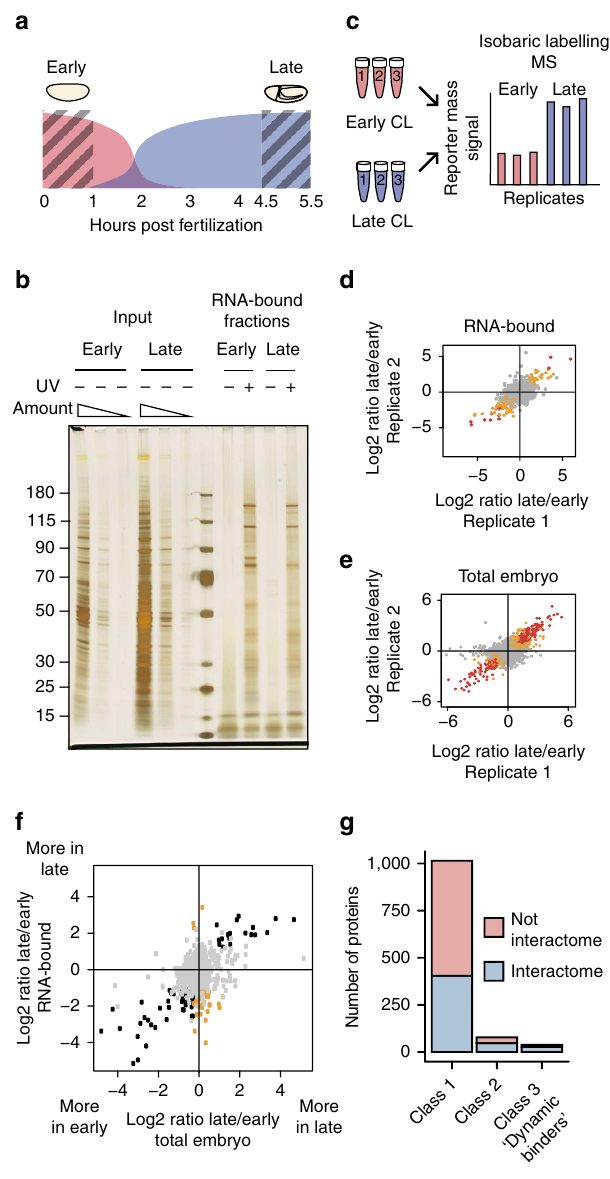
Figure 4 | Study of RNA interactome dynamics during the maternal-to- zygotic transition. ( a ) Schematic representation of the MZT. Shaded areas show the time frames considered in our study. ( b ) Proteins captured from three biological replicates of CL early (0–1h) and late (4.5–5.5h) embryos were partially digested, labelled by six different TMT labels and analyzed by MS. ( c ) Protein profiles of total lysates and RNA-bound fractions recovered from early and late embryos, noCL and CL. ( d , e ) Ratios of protein abundance late/early in two of the three biological replicates. ( d ) RNA-bound fractions, ( e ) total lysates. Red dots: proteins whose abundance significantly changes at FDR 1%; yellow dots: proteins whose abundance changes at FDR 10%. Supplementary Fig. 3a,c includes the same plots, with P values and Pearson correlation values indicated. ( f ) Scatter plot showing change of average protein abundance early/late in RNA-bound fractions (ordinate) and total protein lysates (abscissa). Grey dots: proteins whose abundance does not significantly change neither in the RNA-bound fraction, nor in the total embryo lysate. Black dots: proteins whose abundance change in the RNA-bound fractions follows the change in the total embryo lysate. Yellow dots: proteins whose abundance in the RNA-bound fraction significantly changes, and is inconsistent with their abundance change in the total protein lysate, suggesting active regulation of their RNA-binding capacity (‘dynamic binders’). ( g ) Numbers of proteins in each of the dynamic classes defined in ( f ). Red: numbers of proteins belonging to the RNA interactome. Blue: numbers of proteins not belonging to the